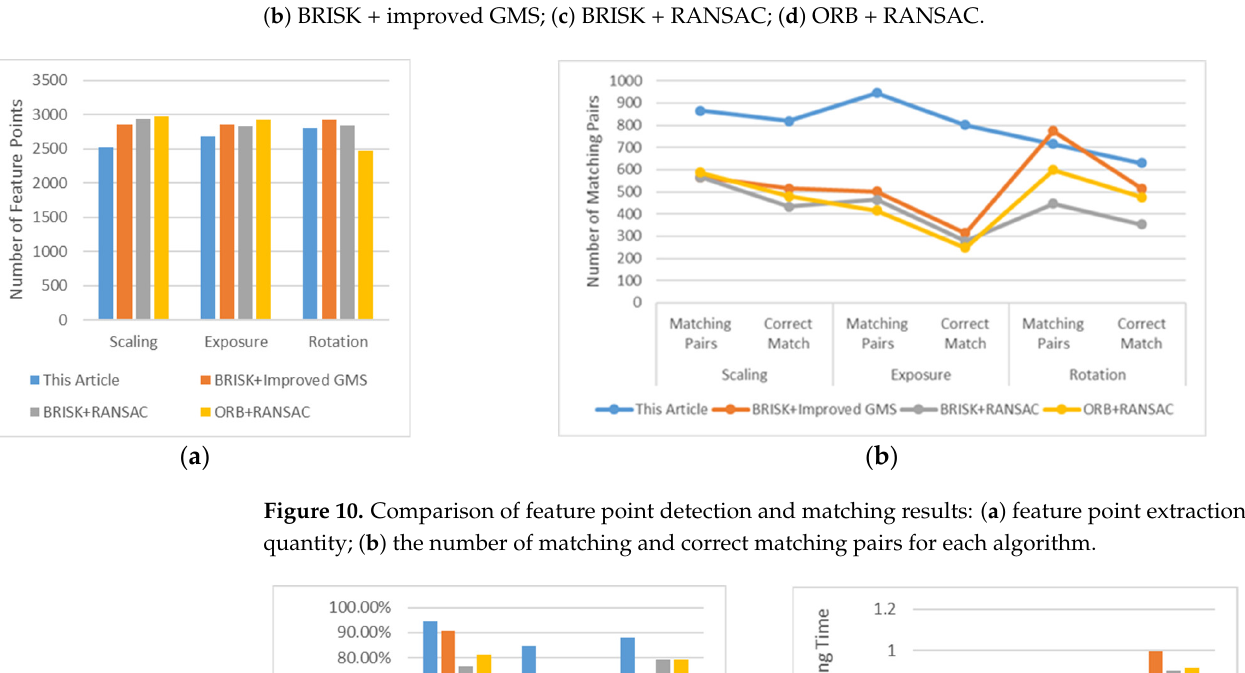
Figure 9. Comparison of feature points extraction and matching results: ( a ) this article; ( b ) BRISK + improved GMS; ( c ) BRISK + RANSAC; ( d ) ORB + RANSAC.